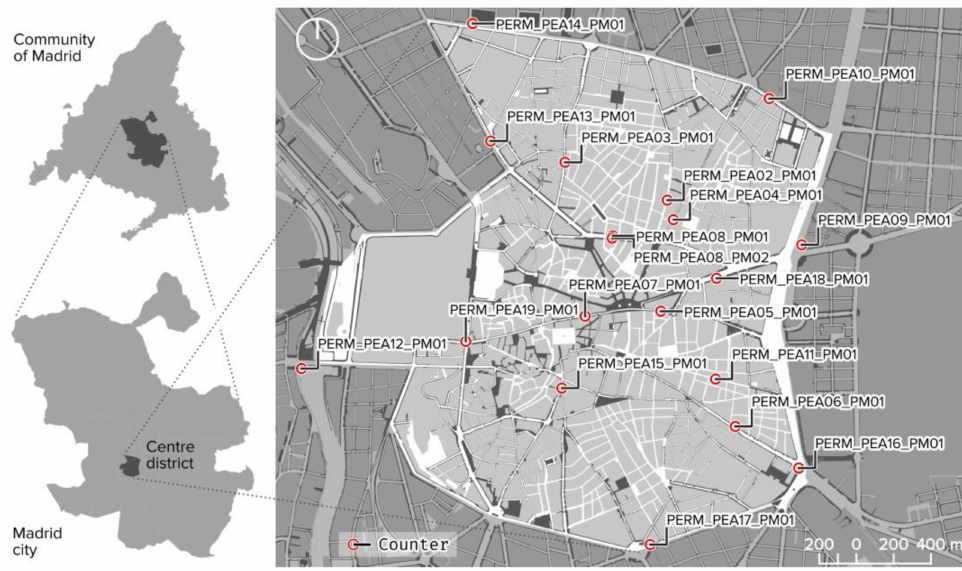
Figure 1. Study area location. Source: Data from [27] and OpenStreetMap